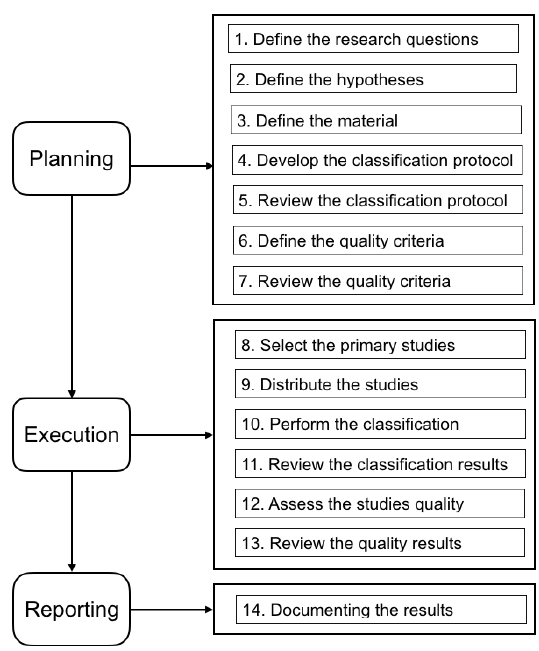
Figure 1. Protocol